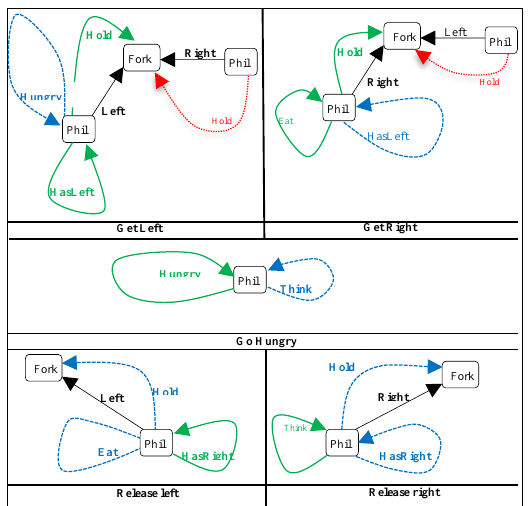
Figure 4. Dining philosopher’s graph transformation rules.